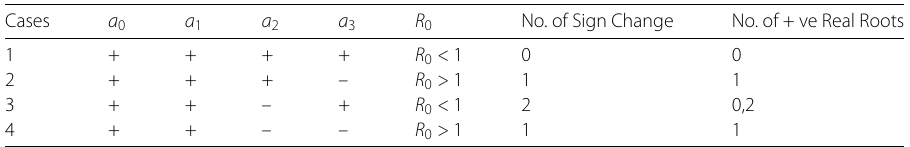
Table 4 Number of possible positive real roots when R 0 < 1 and R 0 >